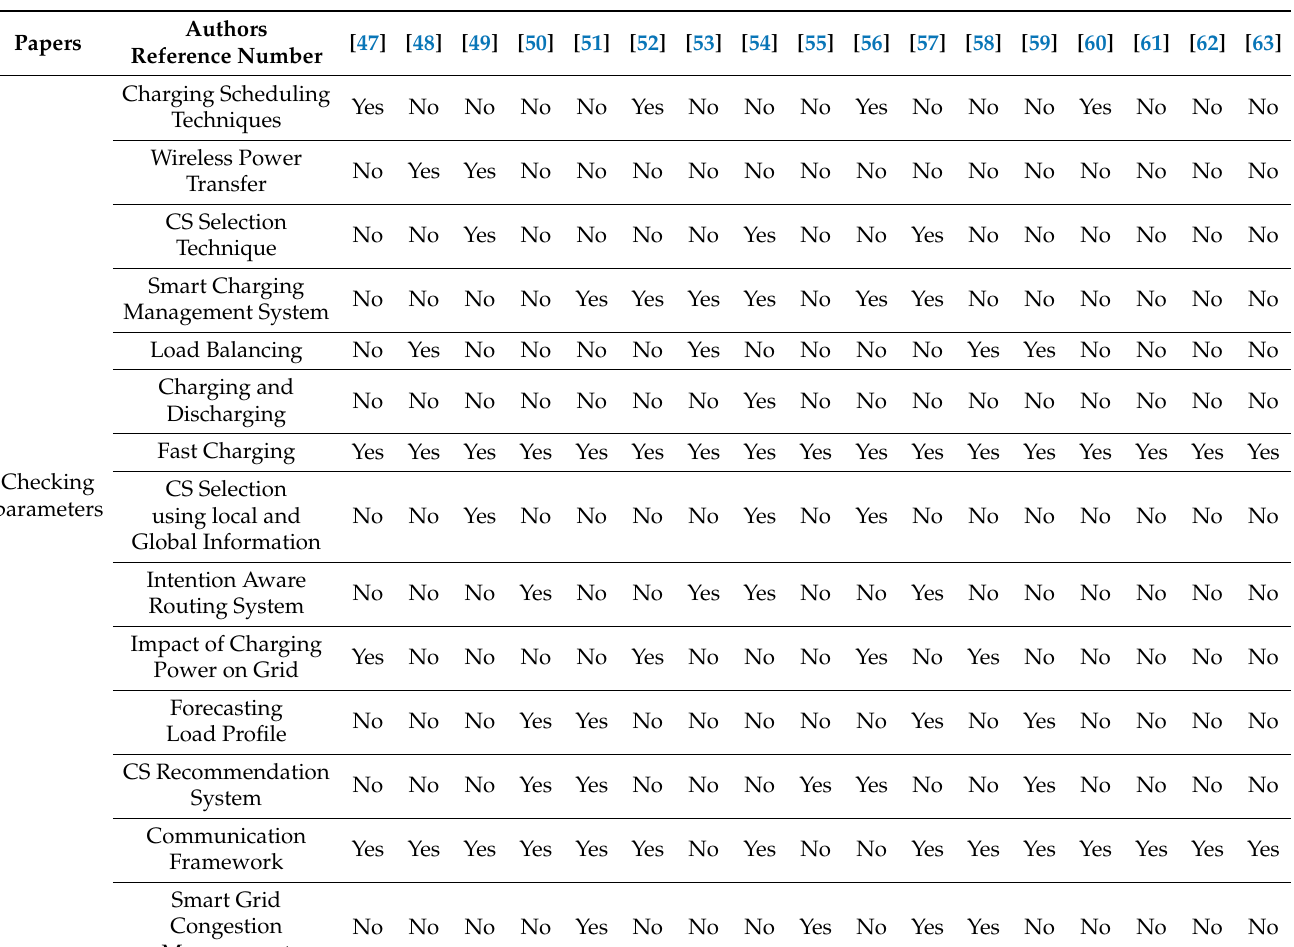
Table 2. Summarize Table of Related